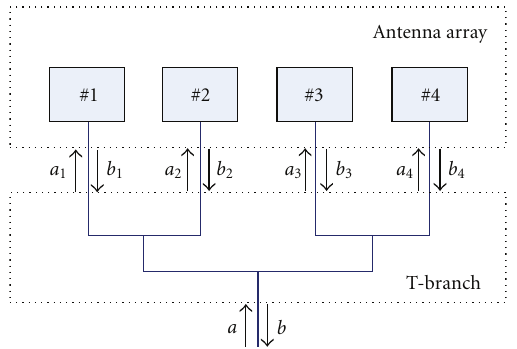
Figure 2: A four-element array fed through a 4-way power divider.